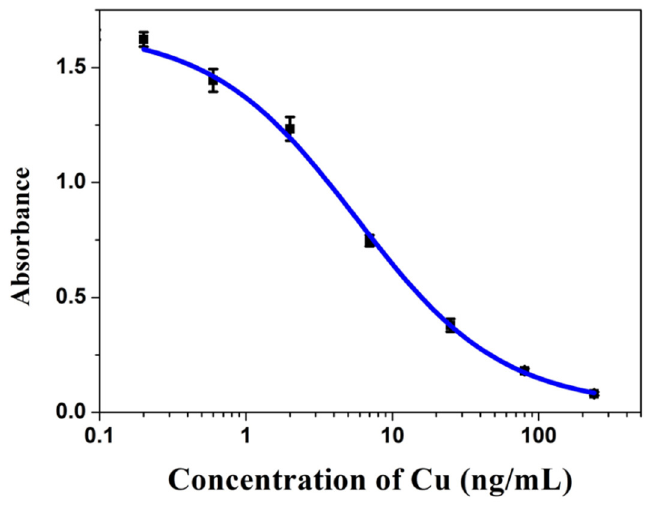
Figure 2. Standard inhibition curve for Cu ions by ic-ELISA method ( n = 3).